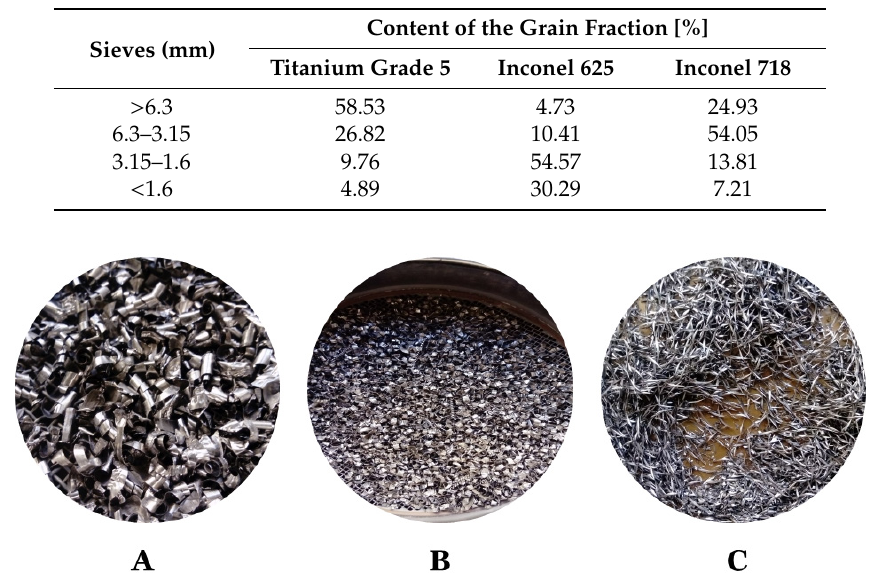
Figure 1. Illustration of a granulometric analysis using the dimensions of 6.3–3.15 mm Titanium Grade 5 ( A ), Inconel 625 ( B ), and Inconel 718 ( C ). Table 1. Granulometric composition of alloy swarfs: Titanium Grade 5, Inconel 625, Inconel 718 in percentage after previous removal of organic parts from the surface.